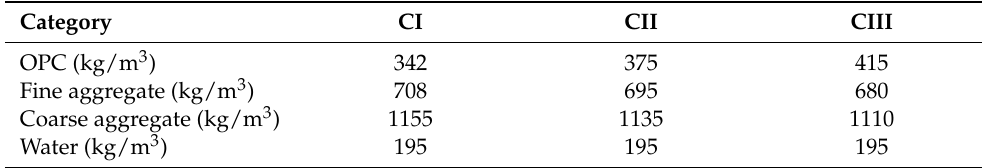
Table 1. Mixture ratio of the concrete